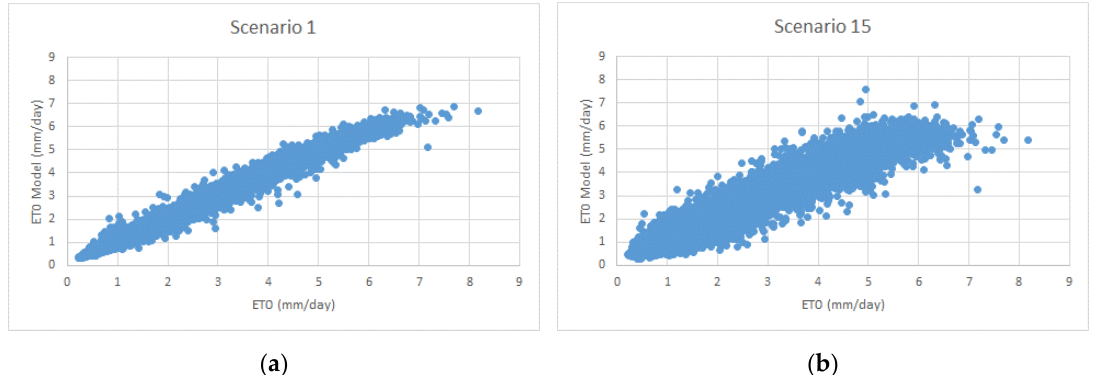
Figure 6. Scatter plot of the RF method for ( a ) Scenario 1 and ( b ) Scenario 15.